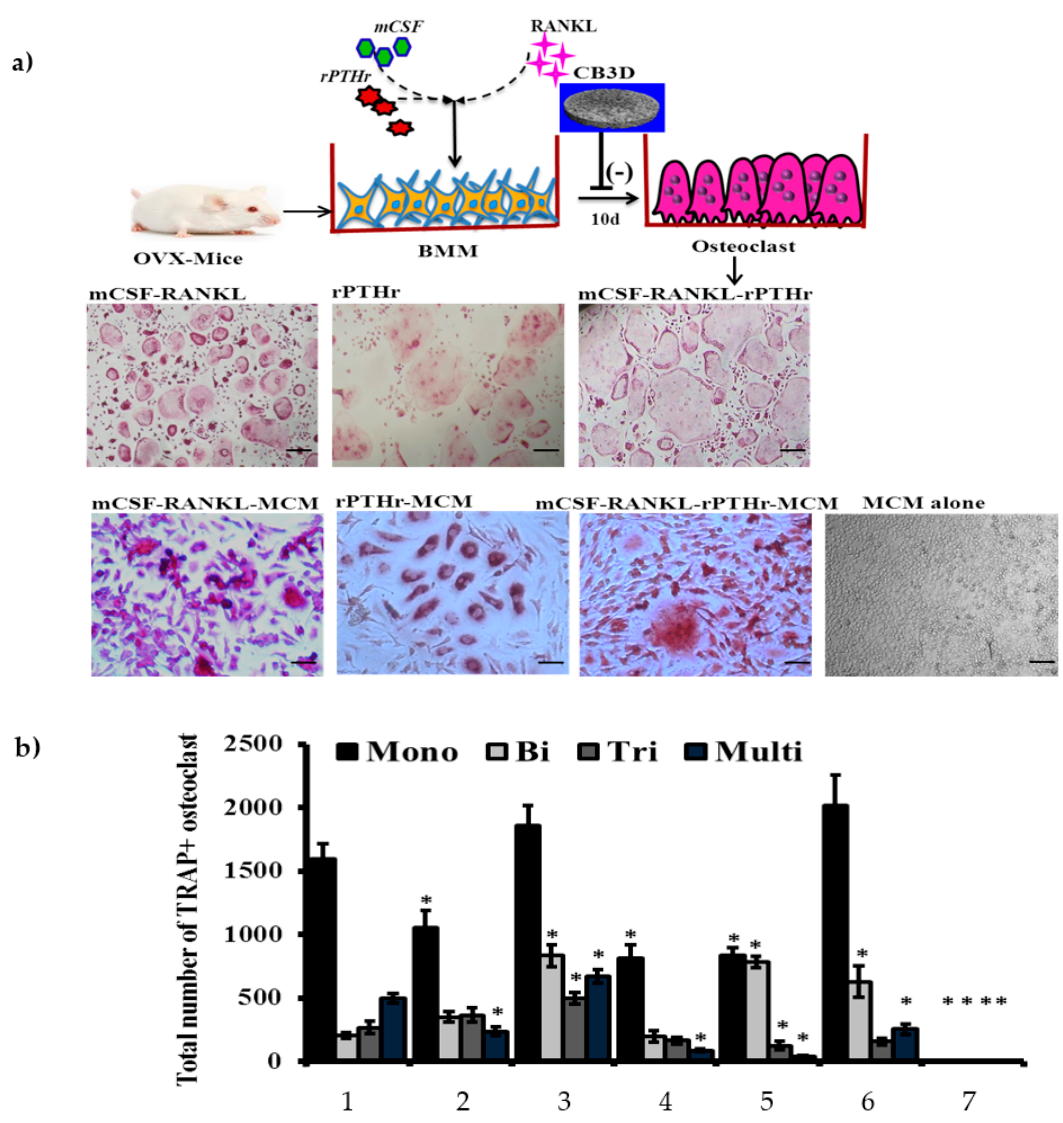
Figure 9. ( a ) E ff ect of inducers (mCSF, RANKL, and rPTHr11) and CCHCs matrix conditioned medium (MCM) on osteoclast formation from ovariectomized mice. ( a ) Tartrate-resistant acid phosphatase (TRAP) positive osteoclast cells; scale bars: 200 µ m. ( b ) Total number (mono-, bi-, tri-, and multi-nucleated) of osteoclasts formed from ovariectomized mice bone marrow macrophages (BMM), 1: mCSF-RANKL, 2: rPTHr11, 3: mCSF-RANKL-rPTHr11, 4: mCSF-RANKL-MCM, 5: rPTHr11-MCM, 6: mCSF-RANKL-rPTHr11-MCM, 7: MCM, * p < 0.05 vs. the mCSF-RANKL-treated group. The osteoclast precursor cells were treated with inducers in the presence or absence of MCM. The combination of mCSF-RANKL-rPTHr11 supported mature osteoclast formation. No osteoclasts formed in the MCM alone group. The experiments were done three times with similar results.